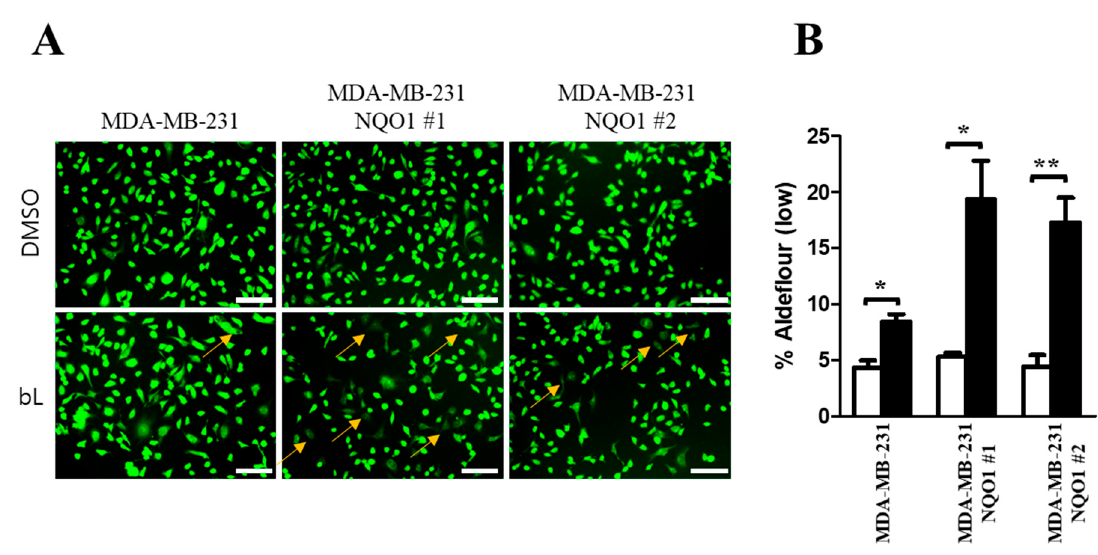
Figure 5. The bL compound decreases endogenous ALDH1 activity. ( A ) The overall activity of ALDH1 was examined using an ALDEFLUOR assay in MDA-MB-231 and two independent clones of NQO1 stable cells (NQO1 #1 and #2) treated with bL (2 µ M) for 24 h. Green fluorescence was captured under a new hybrid microscope (Echo, San Diego, CA, USA). The scale bar is 130 µ m. ( B ) For quantification, three independent areas were randomly taken, and cells with a lower intensity of ALDEFLUOR than the dimethyl sulfoxide (DMSO) control were counted. Quantitative analysis revealed that bL efficiently decreased the endogenous activity of ALDH1 in an NQO1-dependent manner. The yellow arrows indicate ALDEFLUOR (low) cells; * p < 0.05; ** p < 0.01.